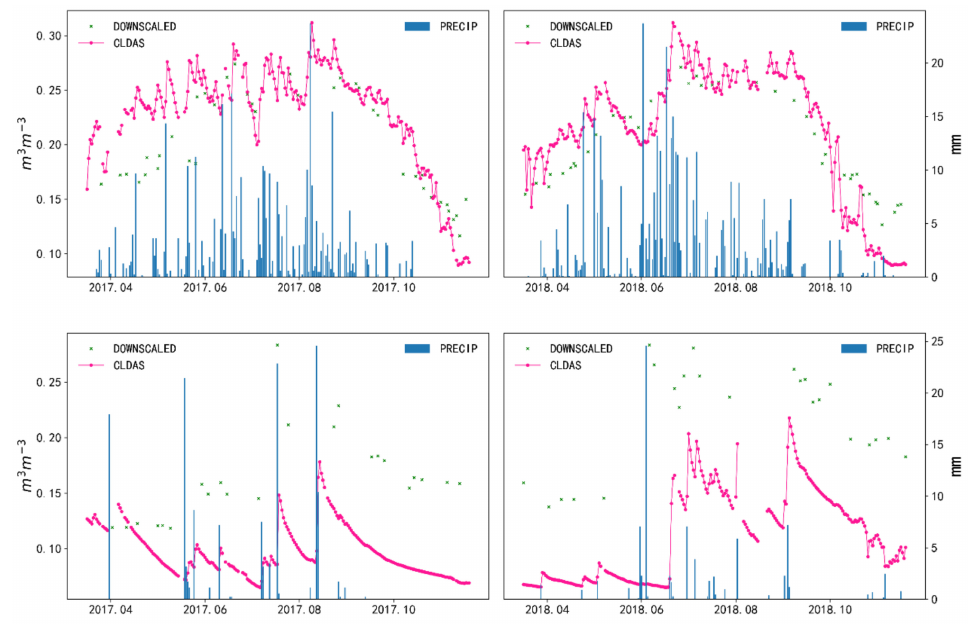
Figure 9. Map of downscaled daily average soil moisture.